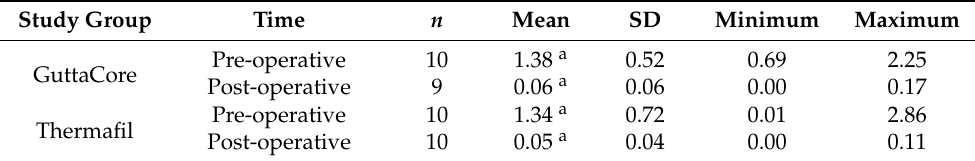
Table 3. Descriptive analysis of the pre-operative root canal filling material volume (mm 3 ) and the remaining post-operative root canal filling material volume (mm 3 ) at the apical third of the root canal systems.